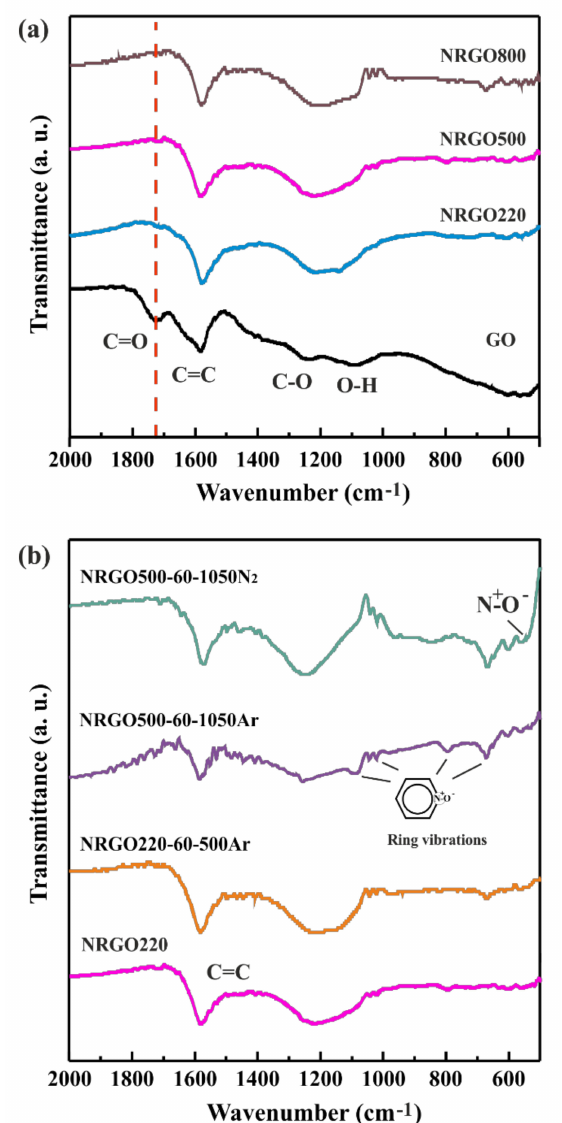
Figure 8. FT-IR of ( a ) GO and 220 ◦ C, 500 ◦ C, and 800 ◦ C ammonia treated GO and ( b ) selected NRGO samples after high-temperature treatments under inert